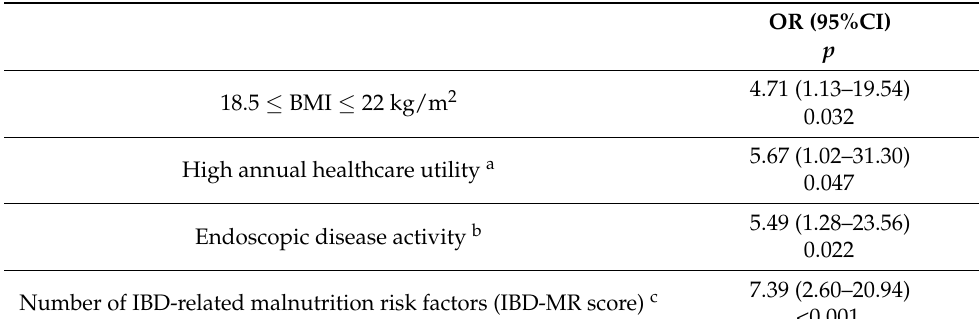
Table 4. Adjusted associations between IBD characteristics and malnutrition development ( n =